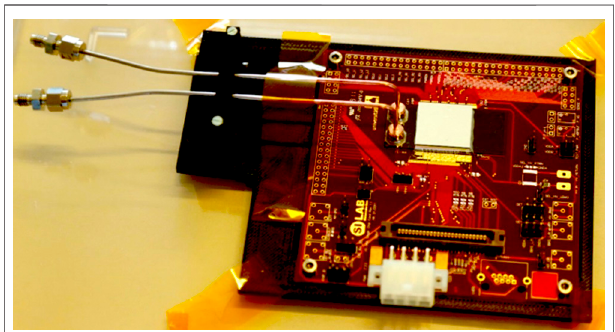
FIGURE3| Picture of the 3D printed black ABS support hosting the FE-I4 compatible PCB, designed at Bonn University, and the support for the stainless-steel inlet – outlet pipes. The 4 cm 2 vertically integrated 3D sensor is visible in the center (white square). On the left, the copper-plated Kovar connectors are connected (soldered) to the microchannel